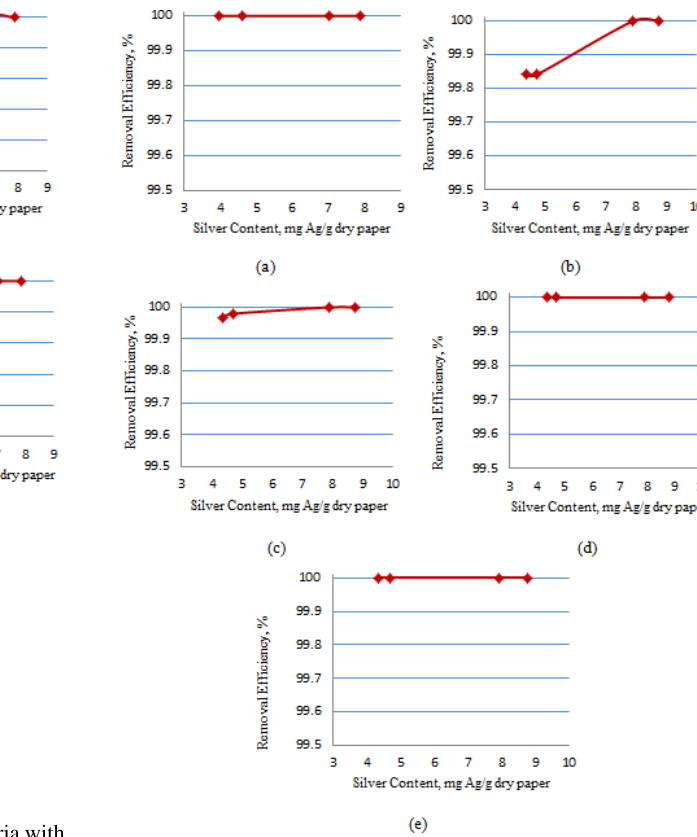
Figure 3. The removal efficiency of different types of bacteria with NaBH 4 / AgNO 3 ratio of 2 : 1: (a) E. coli , (b) Staphylococcus au- reus , (c) Enterococcus faecalis , (d) Enterobacter aerogenes and Klebsiella pneumoniae , and (e) Proteus mirabilis . 4.01 mgAgg − 1 dry paper for 2 : 1 ratio and 4.7 mgAgg − 1